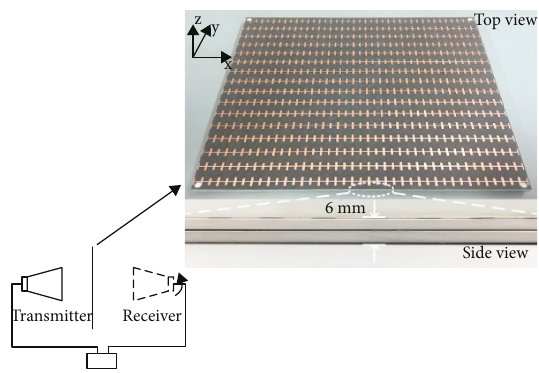
Figure 6: The measurement procedure and two views (top and side views) of the fabricated polarization